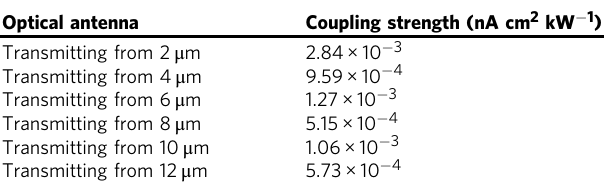
Table 1 Coupling strength between the optical nanoantennas and the